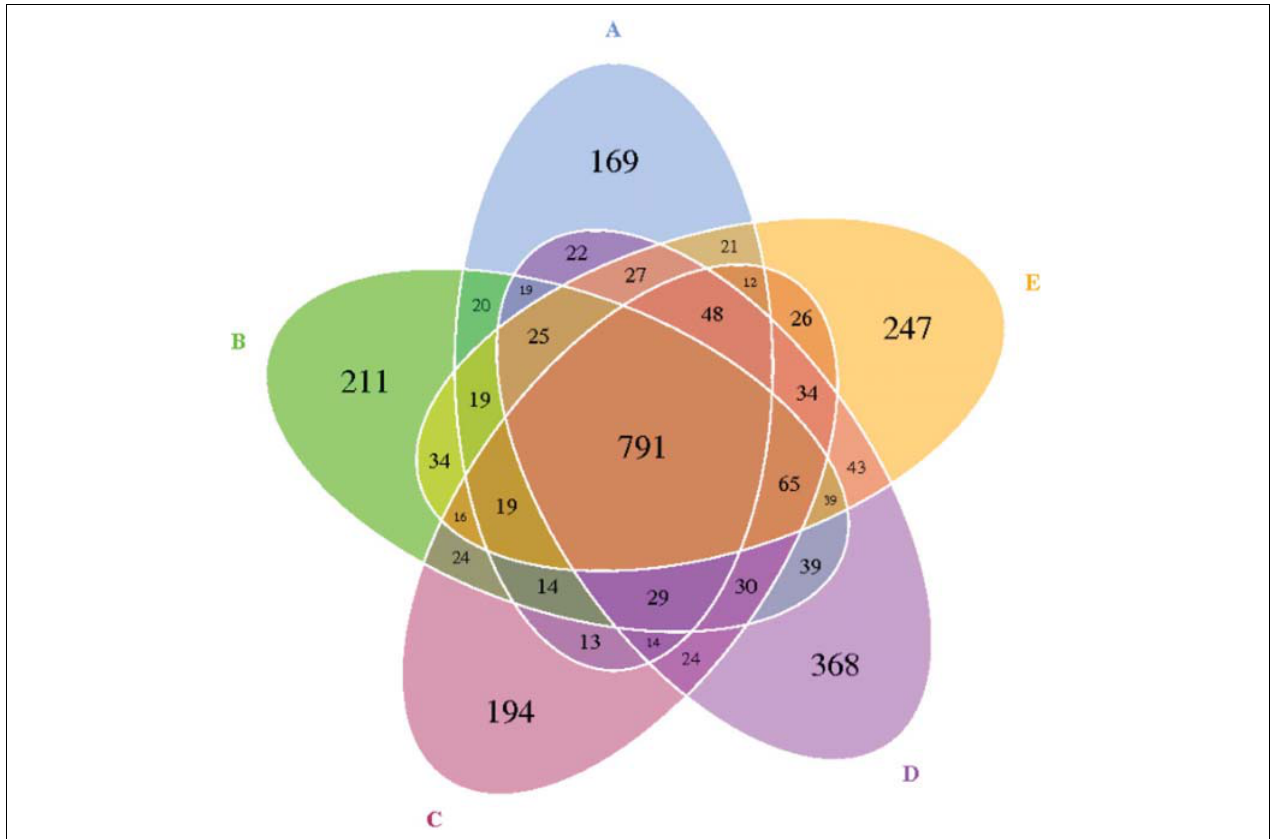
FIGURE 1 | The Venn diagram of the shared and unique OTUs between different DAR groups. DARs of (A–E) were 0.00, 0.20, 0.40,0.60, and 0.80 respectively.